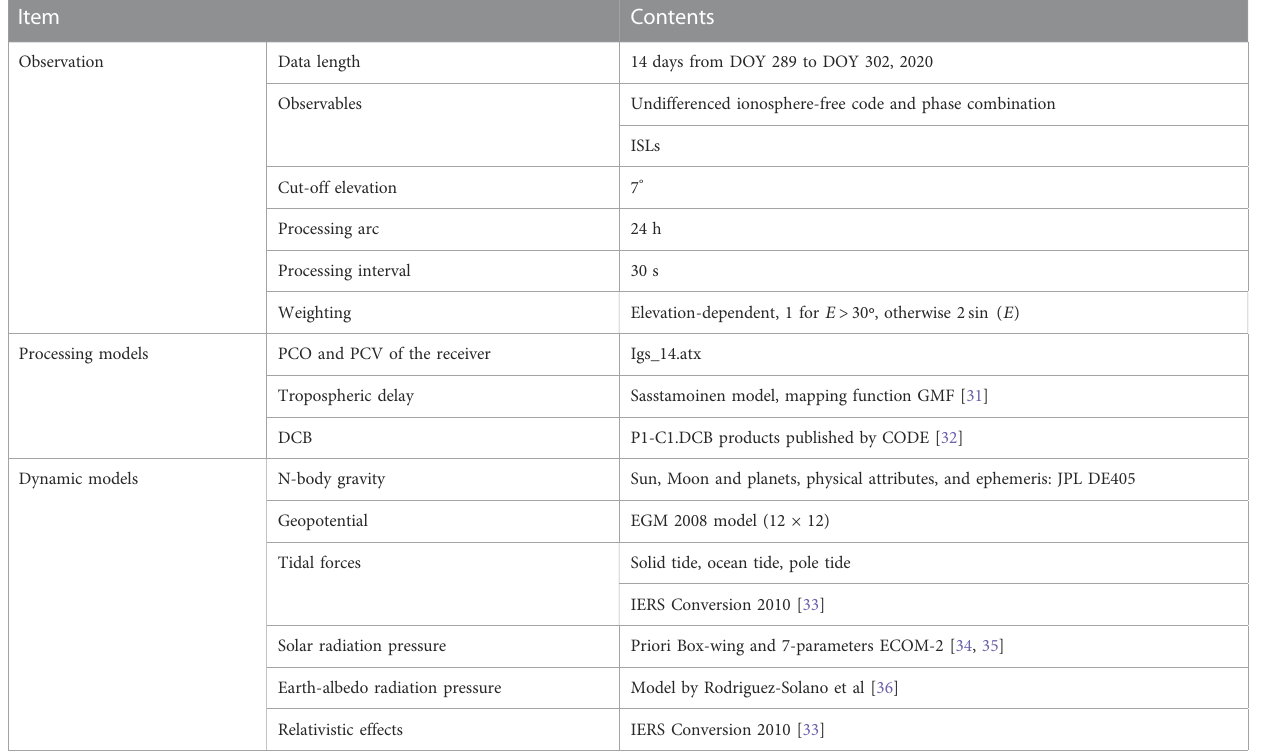
TABLE 1 Processing strategies, models, and estimated